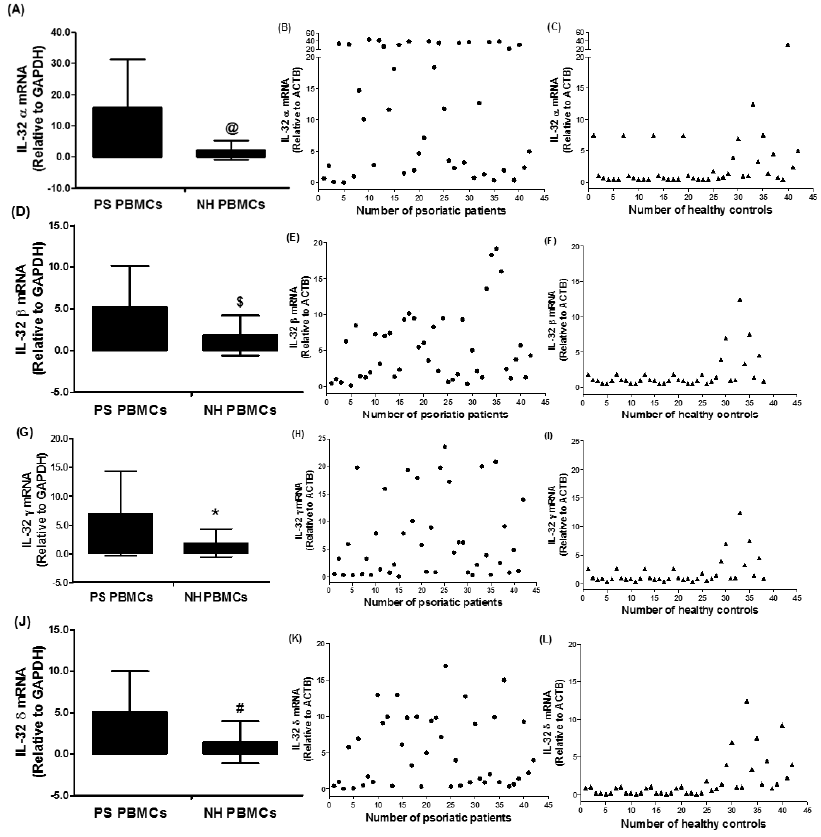
Figure 2. Gene expression of human interleukin (IL)-32 subtypes in the peripheral blood mononuclear cells (PBMCs) of chronic psoriatic patients. ( A – C ) Gene expression of IL-32 alpha (IL-32 α ) in PS PBMCs and NH PBMCs. @ p < 0.01 versus PS PBMCs. ( D – F ) Gene expression of IL-32 beta (IL-32 β ) in PS PBMCs and NH PBMCs. $ p < 0.05 versus PS PBMCs. ( G – I ) Gene expression of IL-32 gamma (IL-32 γ ) in PS PBMCs and NH PBMCs. * p < 0.05 versus PS PBMCs. ( J – L ) Gene expression of IL-32 delta (IL-32 δ ) in PS PBMCs and NH PBMCs. # p < 0.05 versus PS PBMCs. Expression of IL-32 subtypes was determined by real-time qRT-PCR using either GAPDH or β -actin as an endogenous control in the comparative ∆∆ CT method. Data in column chart are representative (mean ± SD) of experiments with PBMCs obtained from psoriatic patients ( n = 42) and normal healthy subjects ( n = 38). PS PBMCs, psoriatic patients PBMCs; NH PBMCs, normal human PBMCs. Comparison analysis was performed using a two-tailed t-test using Mann–Whitney